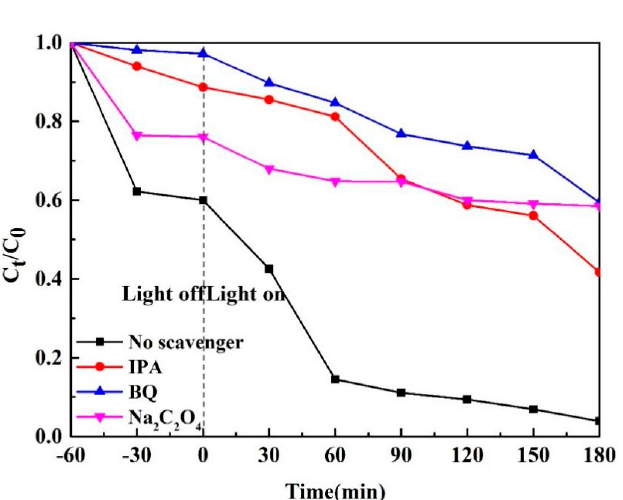
Figure 16. Effect of different scavenger on photocatalytic degradation of RhB by 400 °C 1 − Ce/UN.